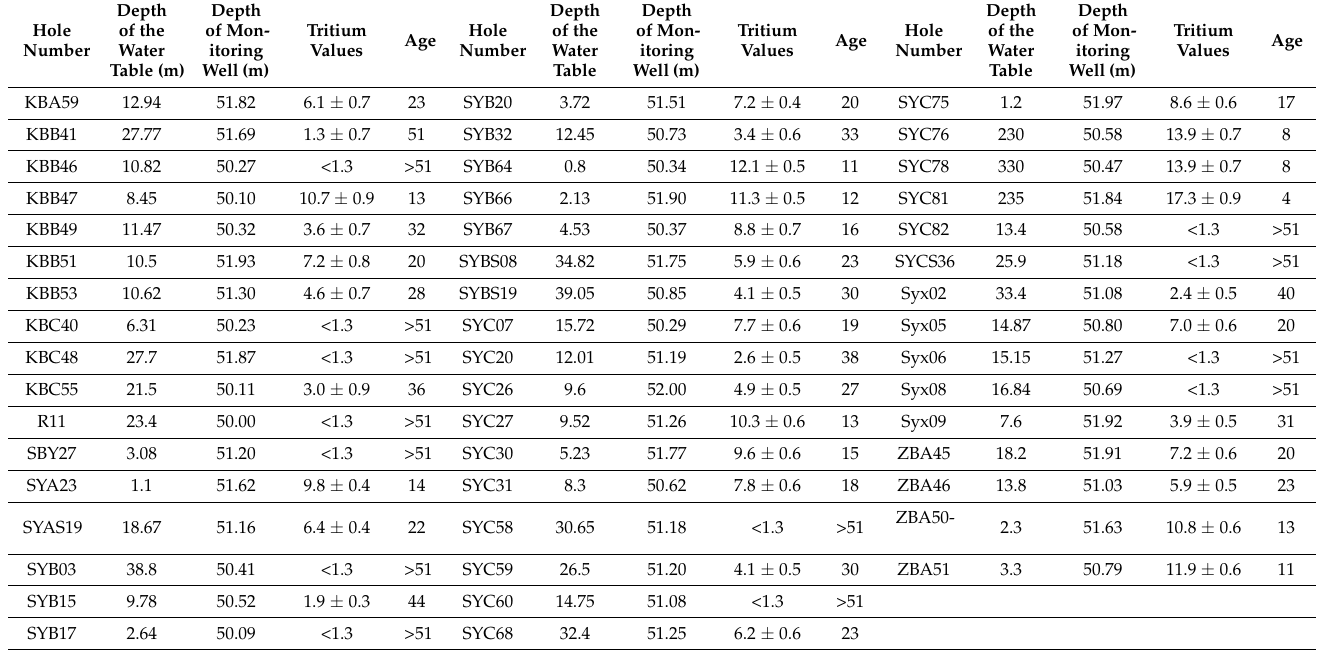
Table 2. Shallow groundwater ages calculated by tritium